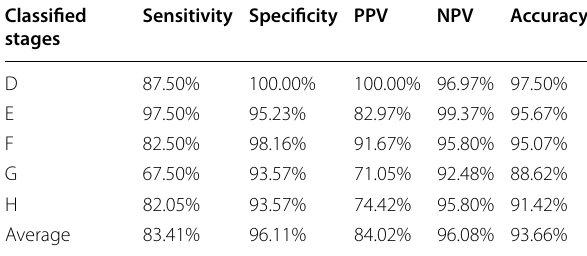
Table 2 Evaluation metrics in each classified